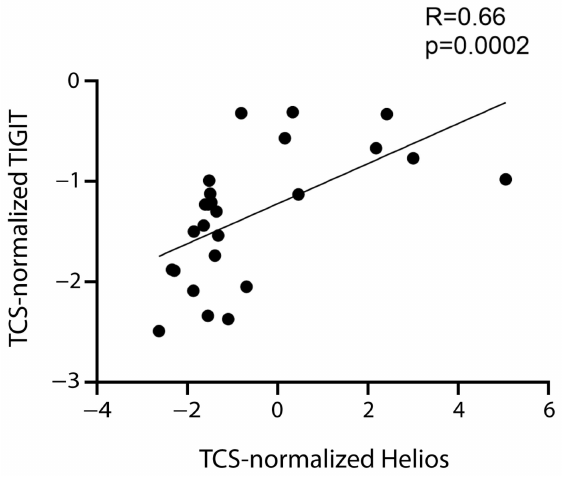
Figure 4. Correlation between TIGIT and Helios. Correlation between normalized mRNA expres- sion (log2) of TIGIT and Helios. The rho factor of correlation (R) and significance evaluated using the Spearman test are